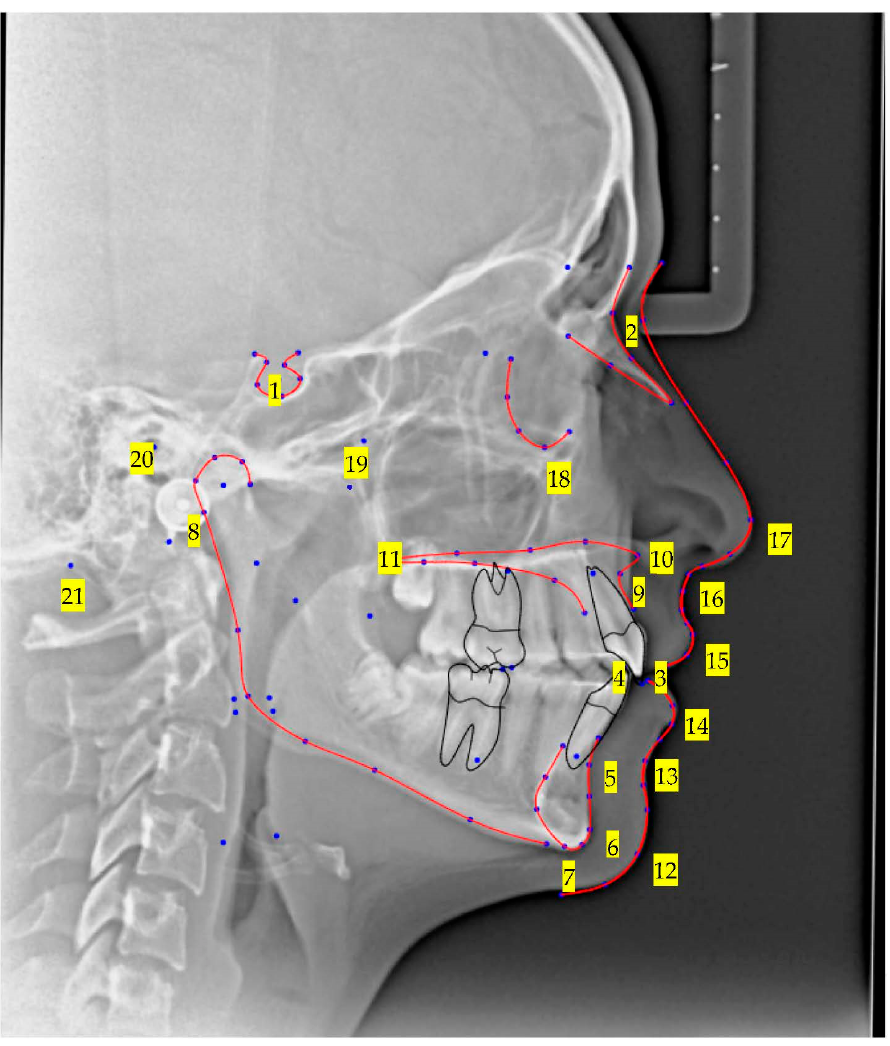
Figure 1. Localization of the 21 lateral cephlometric landmarks used in the present study as defined by Jacobson and Jacobson (see Table 1). Table 1. Description of hard and soft tissue cranial landmarks used for comparative evaluation of human and AI detection.